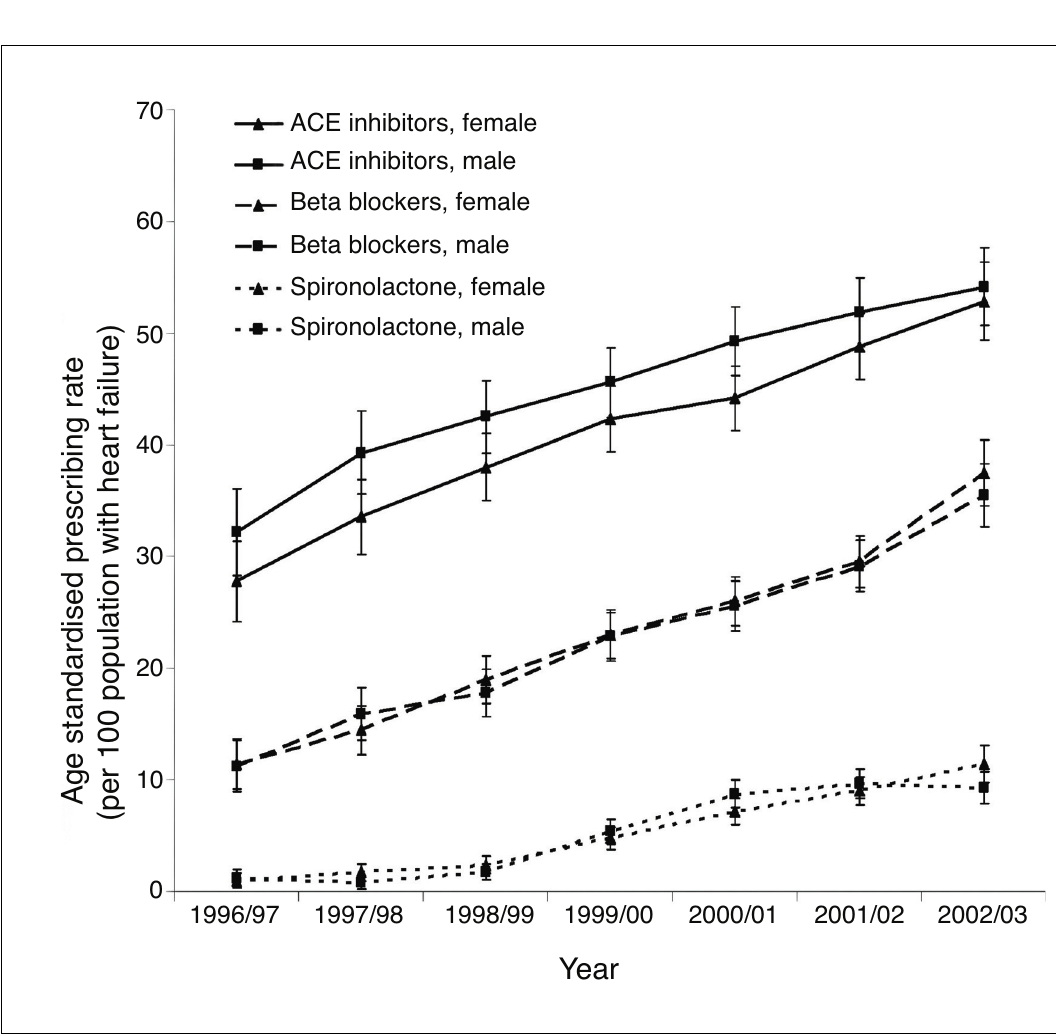
Figure 1. Changes in age-standardised prescribing rates between 1996 & 2003. 15 ACE = angiotensin converting enzyme. Reproduced with permission of Circulation & Wolters Kluwer Health,